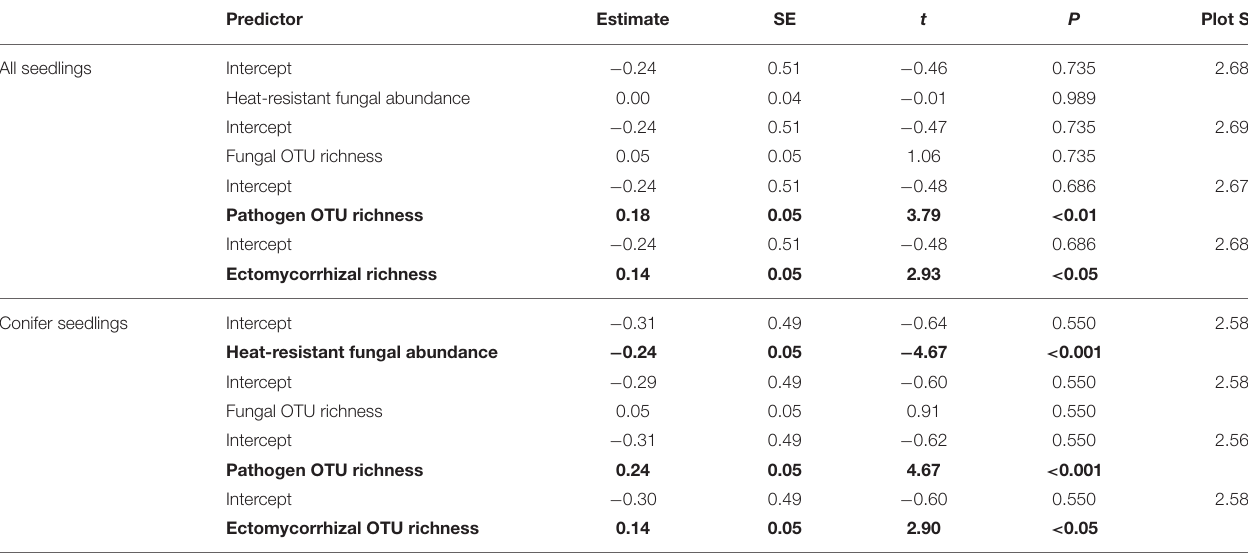
TABLE 4 | Summary of linear mixed-effect models of quadrat seedling densities (per m 2 ) for all species and for conifers only against predictors of fungal community structure: heat-resistant fungal relative abundance, fungal operational taxonomic unit (OTU) richness, pathogen OTU richness, and ectomycorrhizal OTU richness, based on high throughput sequencing in burned boreal forests, Northwest Territories,